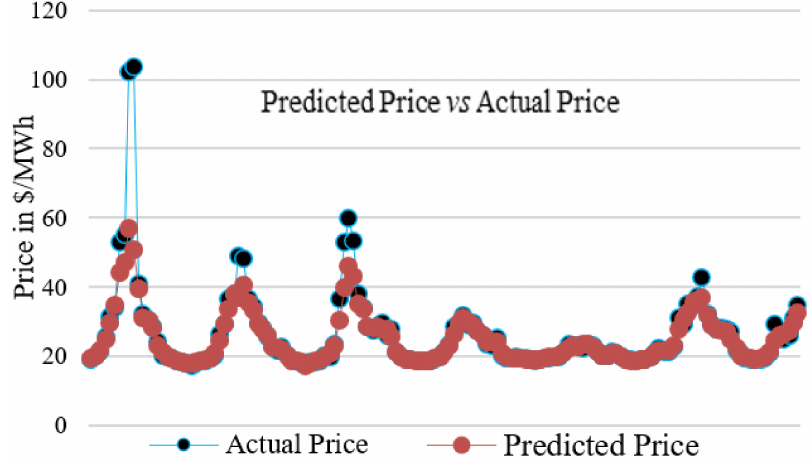
Figure 9. Hour-ahead forecasted settlement point price by the LRCN model vs. the actual price.